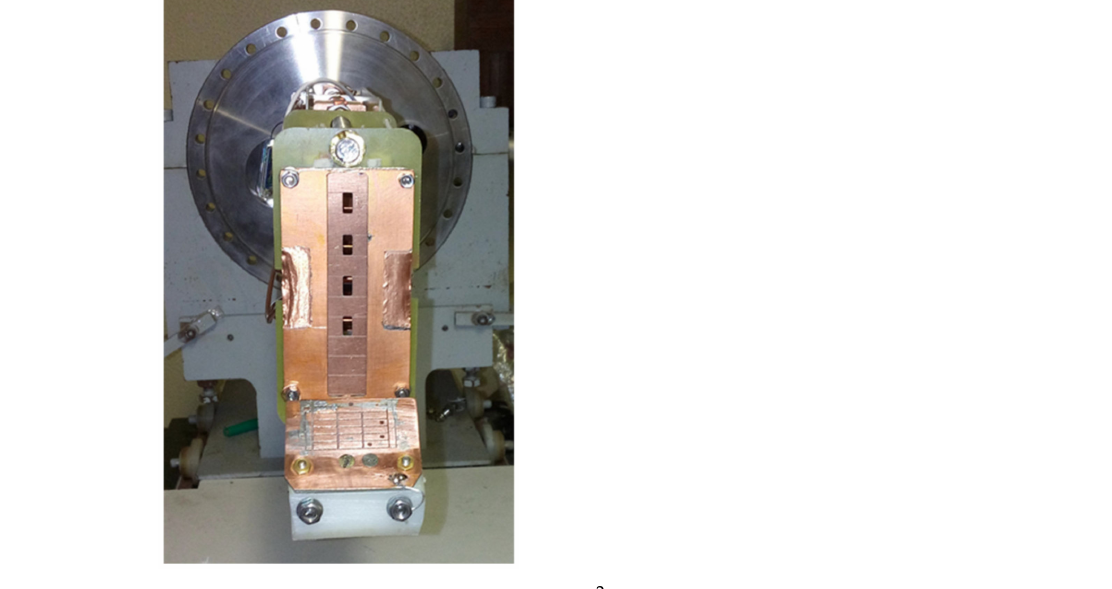
Figure 26. Front MCAD for measuring the X 2+ z-positions. Four apertures in the front MCAD allow for the passage of four secondary beams that are directed to the cylindrical energy analyzer, placed behind the circular flange shown in the picture.